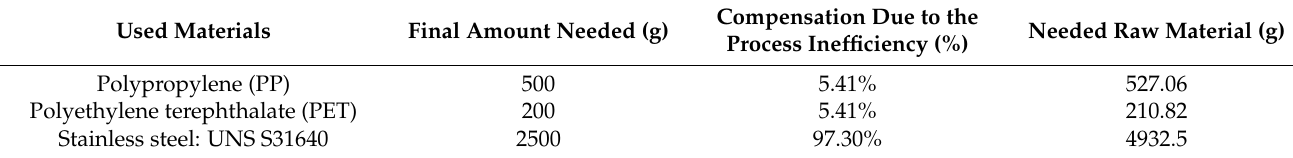
Table 26. Amount of raw material to be treated considering the final product weight and the inefficiencies registered for each process used (Table